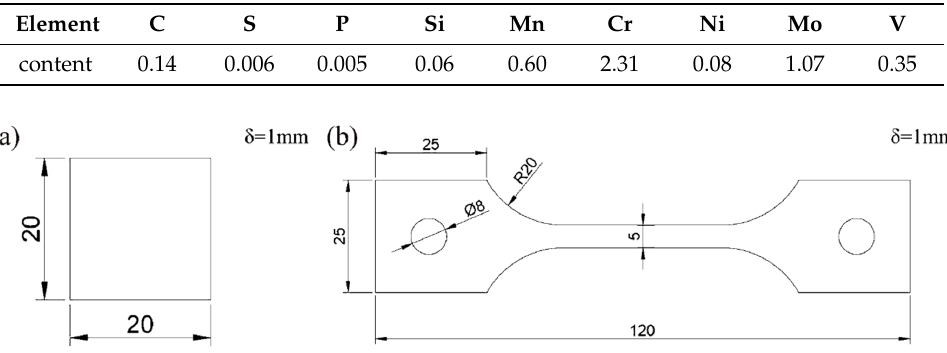
Table 1. Chemical composition of test specimen (wt %).